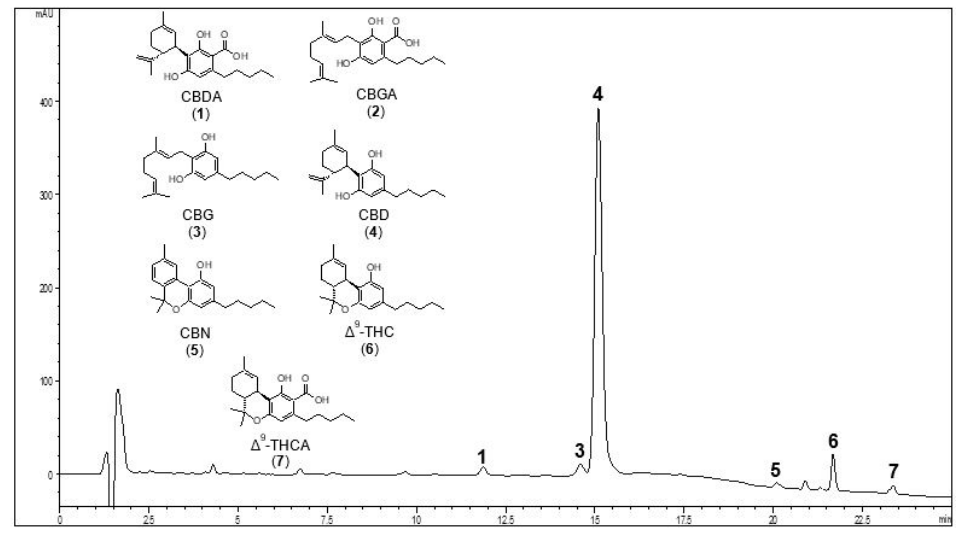
Figure 1. Representative HPLC-UV chromatogram of hemp oil 2 (K2) recorded at 210 nm. The peaks of the main neutral and acid cannabinoids are shown. For peak identification, see Table 2. The chemical structures of the compounds selected for quantitative analysis are shown in the slot on the left. Table 2. Quantification of cannabinoids in hemp oils using HPLC-UV. Data expressed as mg/mL ± SD. Peak